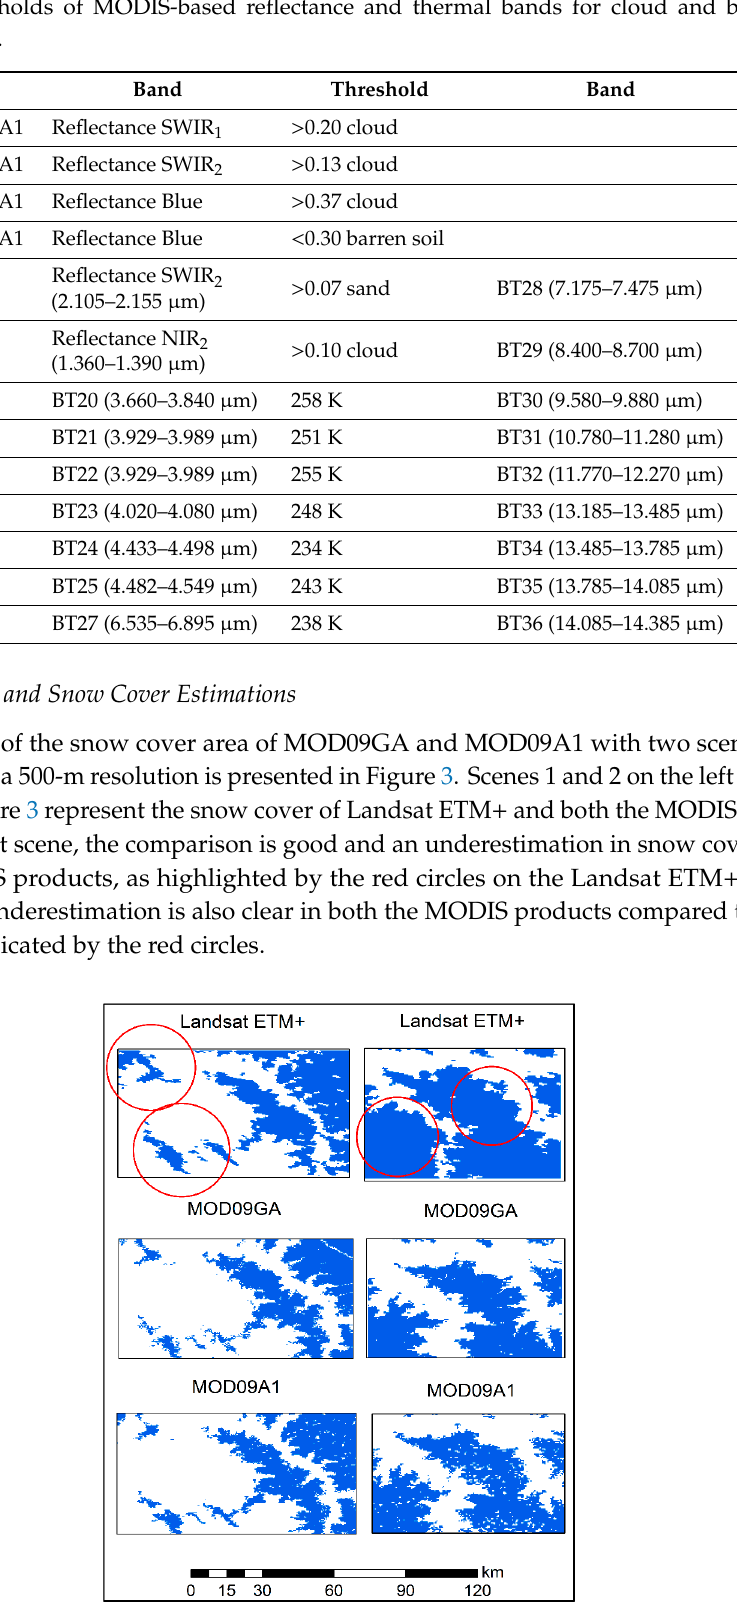
Figure 3. Comparison of two scenes of MOD09GA and MOD09A1 with Landsat ETM+ coarsened to 500-m resolution for 1 January 2009. 500-m resolution for 1 January